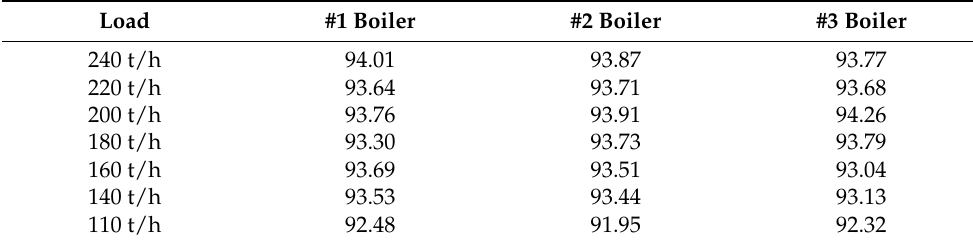
Table 5. Boiler efficiency under load condition of three boilers (%).